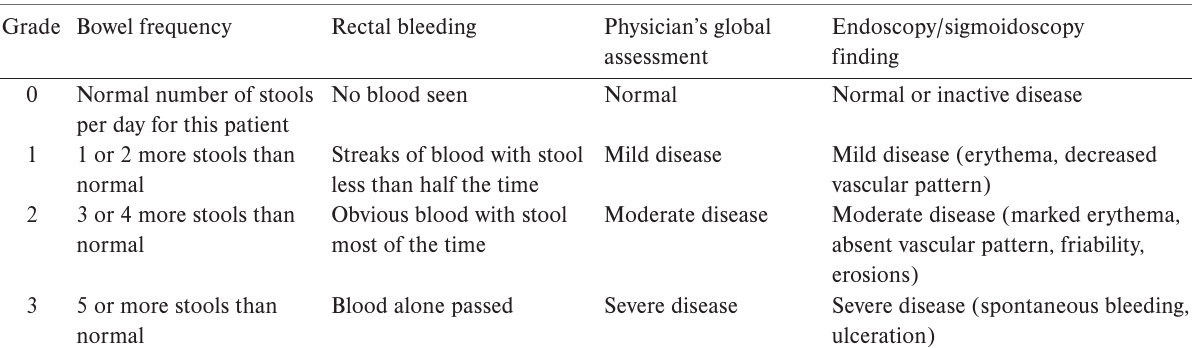
Table 1. modified mayo disease activity index.